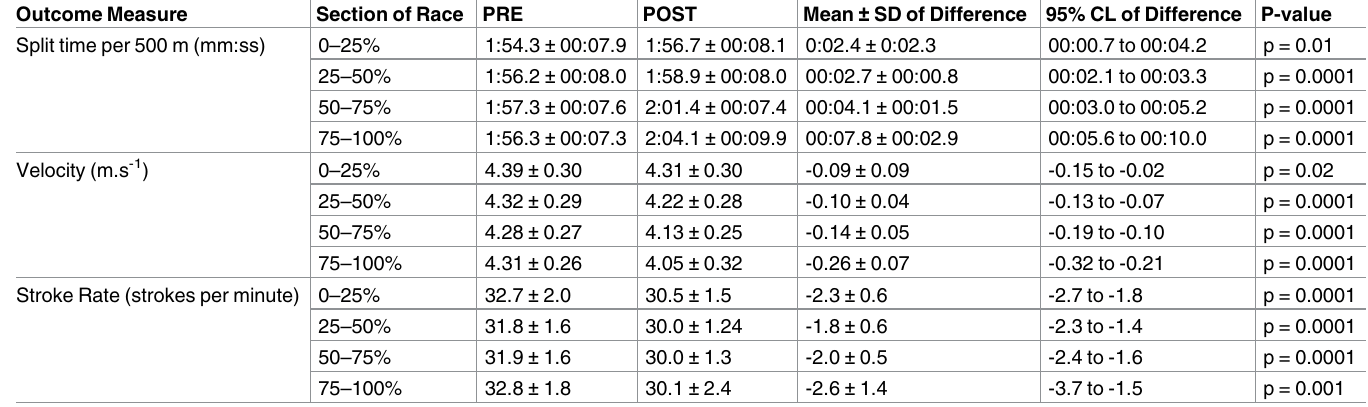
Table 2. 5 km time trial performance PRE and POST the four-week training cycle. Results from paired-samples T-test (POST-PRE) are presented as mean ± SD of difference and 95% CL of difference. Outcome